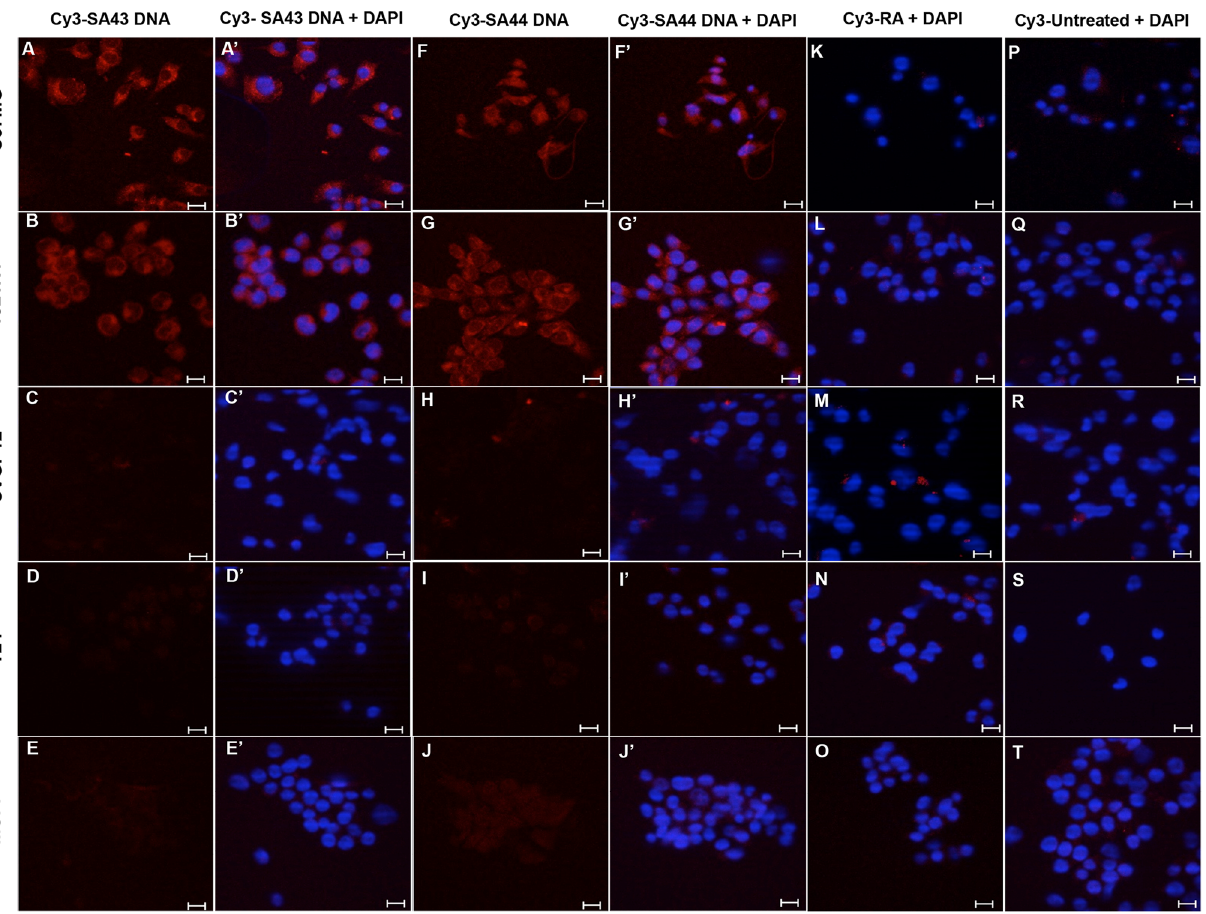
Fig 2. Selective uptake of SA43 and SA44 DNA on various cell lines using confocal microscopy. Cy3 labelled SA43, SA44 (red) and random aptamer (RA) were incubated separately at a concentration of 100 nM on live U87MG, 1321N1, SVGp12, T24 and MCF-7 cells for 90 minutes at 37°C and fixed using 4% PFA. The nuclei were counterstained with DAPI (blue). Cells with random aptamer and media alone were used as control. Z-stacks were acquired under 40x magnifications at an excitation of 543 nm and emission of 560 nm under 1047-camera resolution. Data are representative of three independent experiments with single plane images of middle section of Z- axis. The Cy3 fluorescence signal of the SA44 aptamer on each cell line were compared to the random aptamer and respective untreated controls. A ( A ’ ) and B ( B ’ ) represent Cy3 and merged DAPI image showing high uptake and cytoplasmic binding of SA43 in U87MG cells and 1321N1 cells respectively. C ( C ’ ), D ( D ’ ), and E ( E ’ ) represent Cy3 and merged DAPI image of SA43 showing negligible uptake in SVGp12, T24, and MCF-7 cells, respectively. F ( F ’ ) and G ( G ’ ) represent Cy3 and merged DAPI image showing high uptake and cytoplasmic binding of